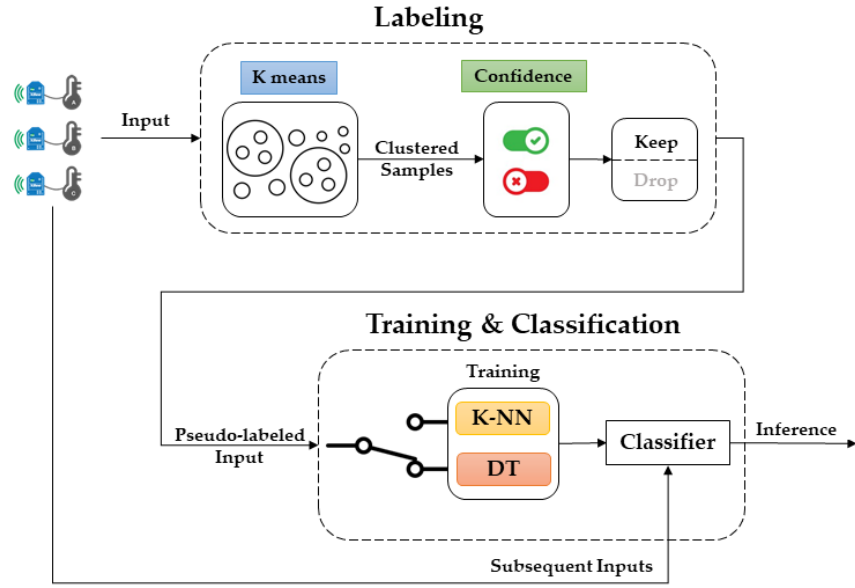
Figure 1. Overview of the AEP.